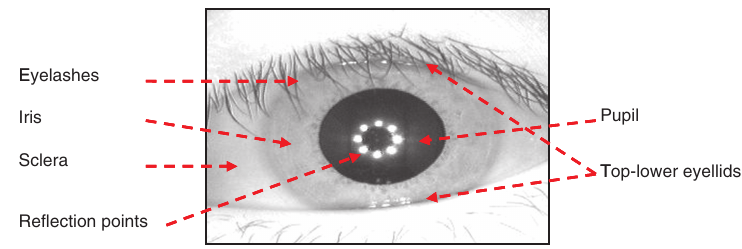
Figure 1. Anatomy of the Human